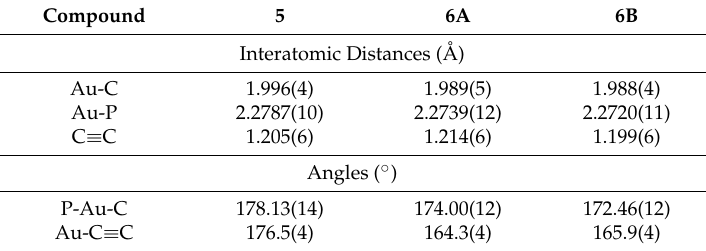
Table 1. Selected bond lengths and angles for 5 and 6 (in 6 , two independent molecules A and B are found in the crystal lattice).